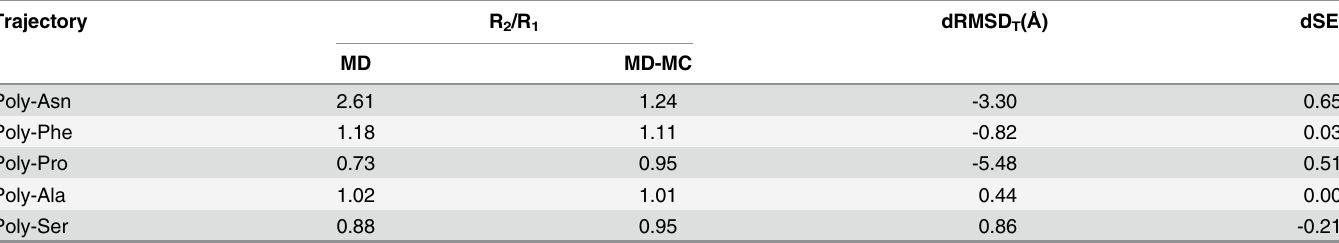
Table 3. The ratio R 2 /R 1 , dRMSD T and dSE for the five representative trajectories shown in Fig